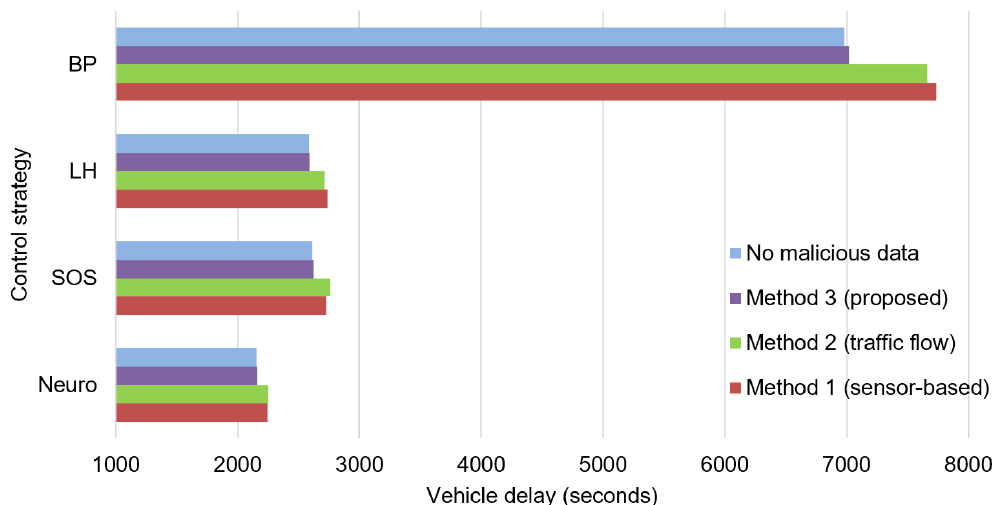
Figure 12. Delay of vehicles for different signal control strategies with and without detection of malicious